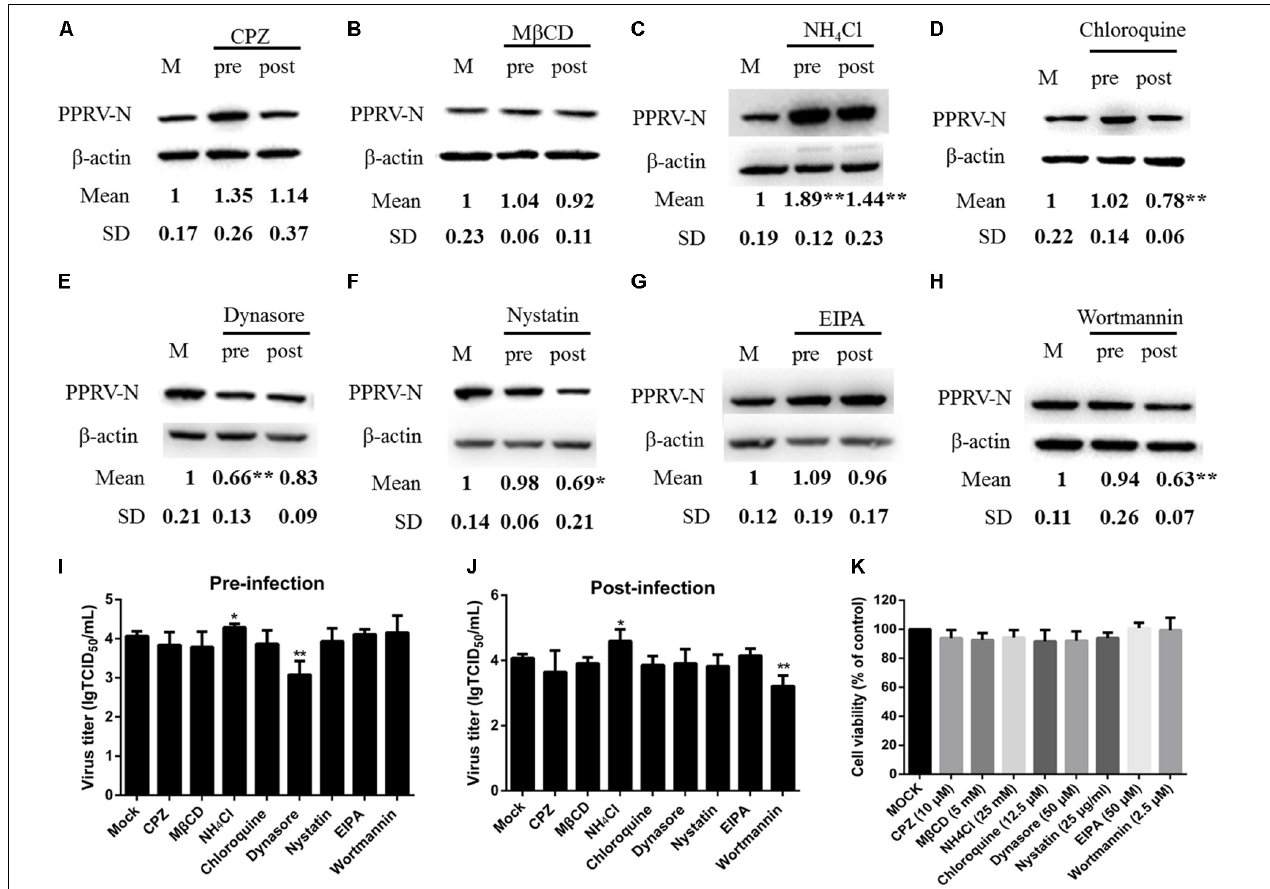
FIGURE 9 | Effects of inhibitors on PPRV entry into FFCs. (A–H) Western blot analysis of the entry and replication of PPRV. Cells were treated with inhibitors 1 h before (Pre) or 1 h after virus addition (Post) and this was maintained during infection. After 12 hpi (PPRV, MOI 10), equivalent amounts of protein were analyzed by western blot with the anti-PPRV-N antibody, and β -actin was used as an internal control. The relative expression level was determined by densitometry. (I,J) Viral titration analysis of the entry and replication of PPRV in pre- and post-treatment samples. (K) The concentration of inhibitors did not affect cell viability in FFCs. All inhibitors were subjected to an MTT assay to evaluate their cytotoxicity toward FFCs that were exposed to the indicated concentrations for 24 h. The bars indicate the mean ± SD from three independent experiments. SD, standard deviation; ∗ P < 0.05; ∗∗ P <